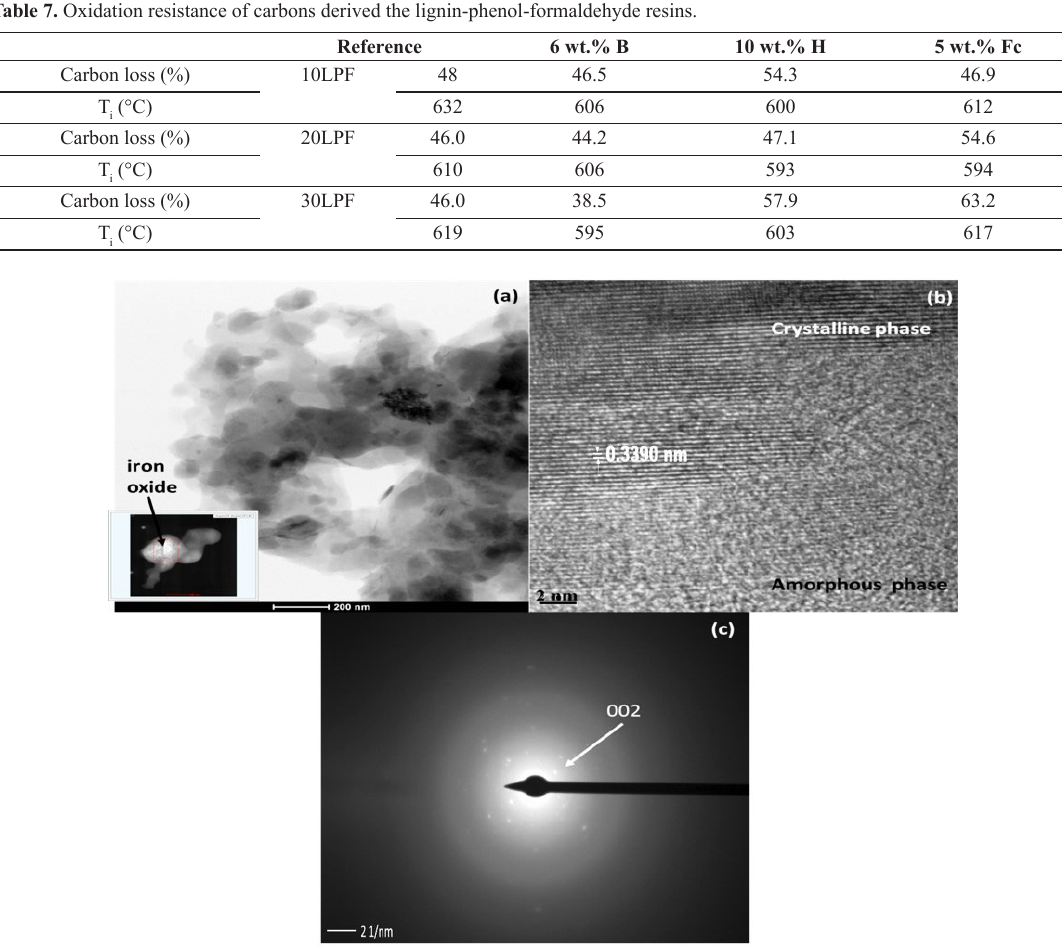
Figure 8. (a) TEM, (b) HRTEM and (c) SAED images of 20LPF-5Fc carbon sample prepared using sequential heat treatment process up to 1500 °C for 5